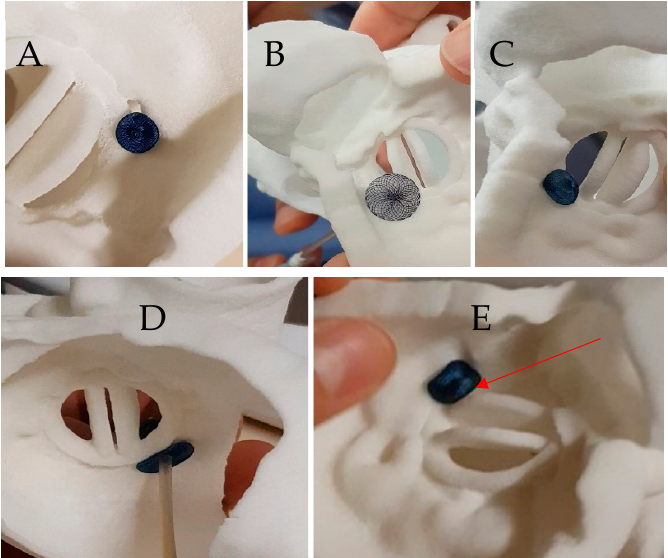
Figure 3. Case 1: Testing of different plugs on the 3D printed model. ( A ) An 8 mm Amplatzer Vascular Plug II with adequate compression but residual leakage is suspected; ( B ) Amplatzer Septal Occluder 4 mm: interference with the mitral prosthesis leaflet (see Video S1); ( C ) Amplatzer Duct Occluder 2: 6-4, unstable when performing a tug test ( D ) Amplatzer Valvular Plug III 12-3: good apposition of the device without residual gap on atrial view (see Video S2), ( E ) Amplatzer Valvular Plug III 12-3 in ventricular view showing a close contact with the disc depending on the orientation of the device (see Video S3).